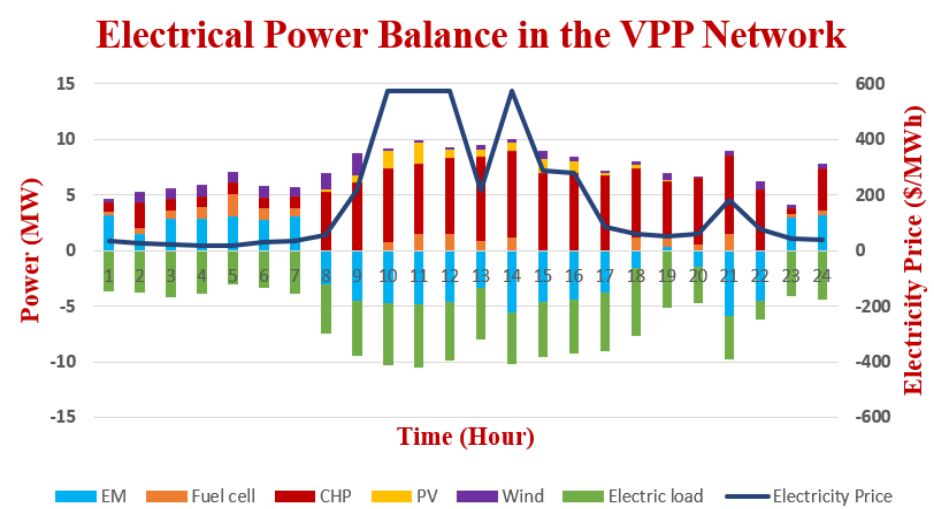
Figure 10. Case I Electrical power balance in the VPP network for 24 h.